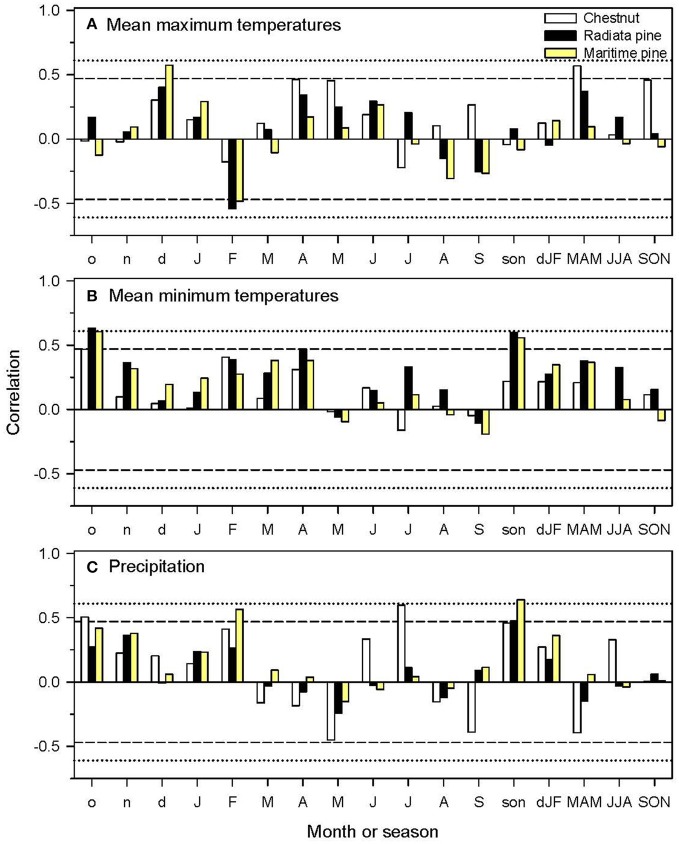
Climate-growth relationships calculated by relating monthly or seasonal climatic variables [(A), mean maximum temperatures; (B), mean minimum temperatures; (C), precipitation] with the mean series of ring-width indices of the three study species (chestnut, radiata pine, maritime pine). The dashed and dotted horizontal lines correspond to the 0.05 and 0.01 significance levels, respectively. Months or seasons abbreviated by lowercase or uppercase letters correspond to the previous and current years, respectively.